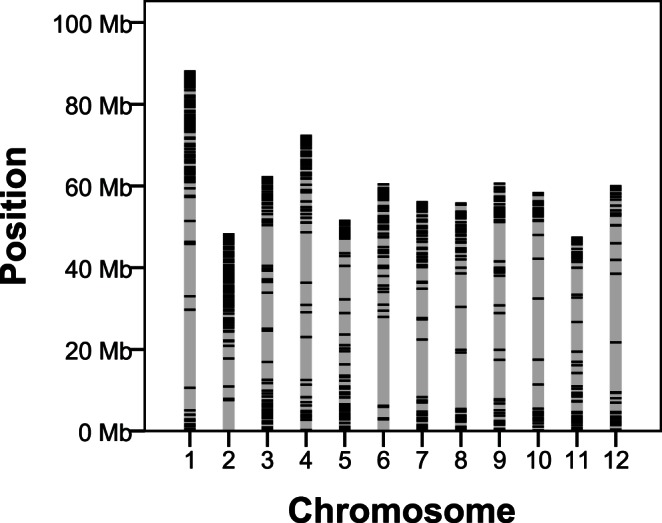
Mapping of resequencing targets onto the potato genome.Physical position of the approximately 800 target genes scattered across the 12 potato chromosomes. Physical positions are ordered according to the latest pseudomolecule order (v.3 beta). The distribution of the ∼800 genes reflect the physical proportions of gene rich chromosome arms and gene poor heterochromatic regions.